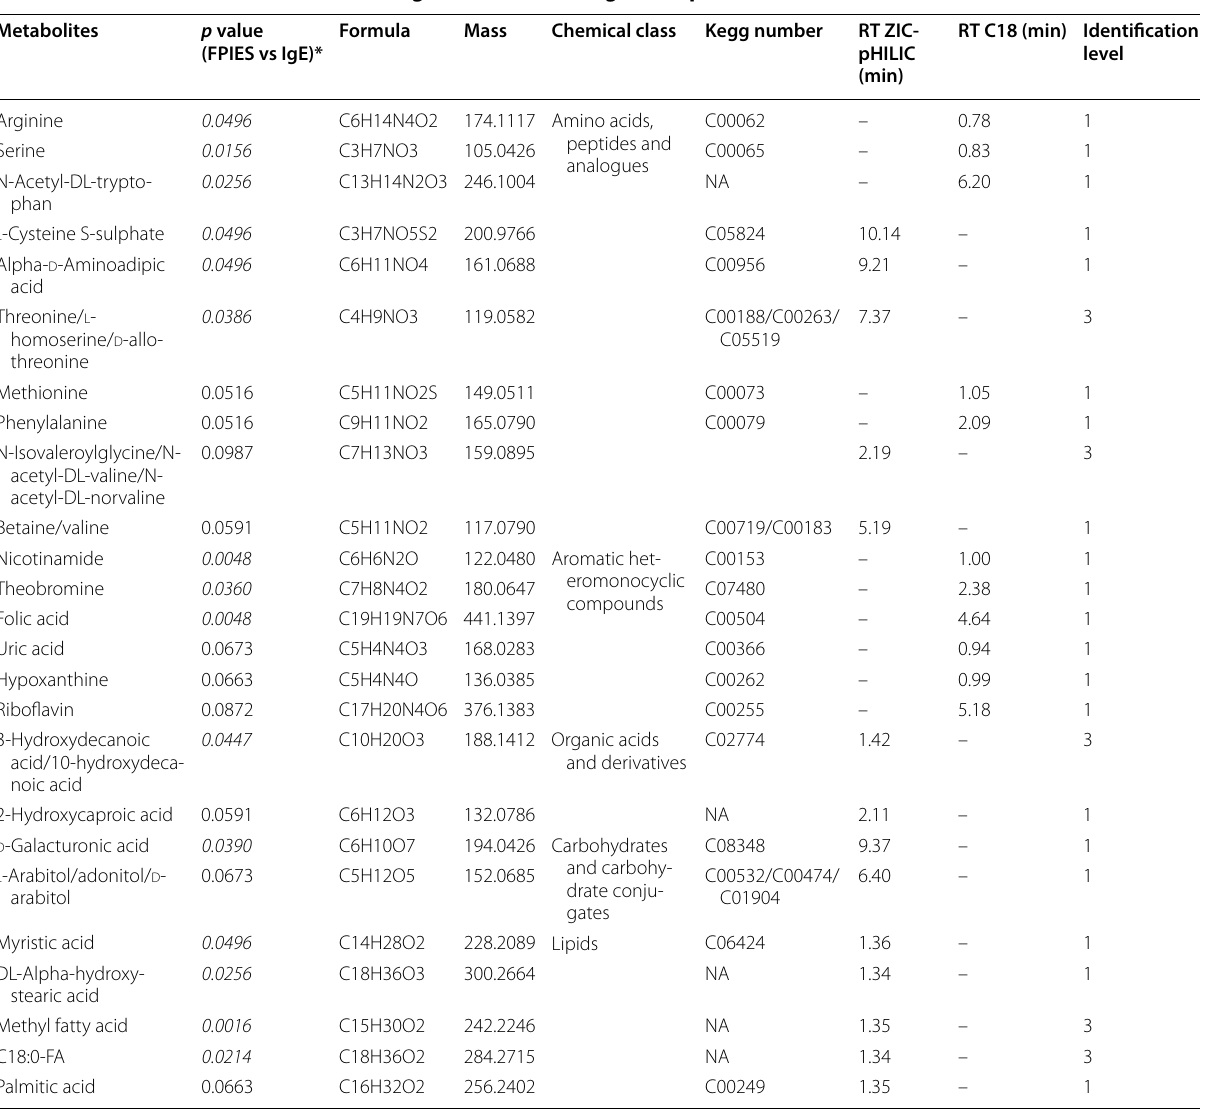
Table 3 Plasma metabolites discriminating CM-FPIES versus IgE-CMA